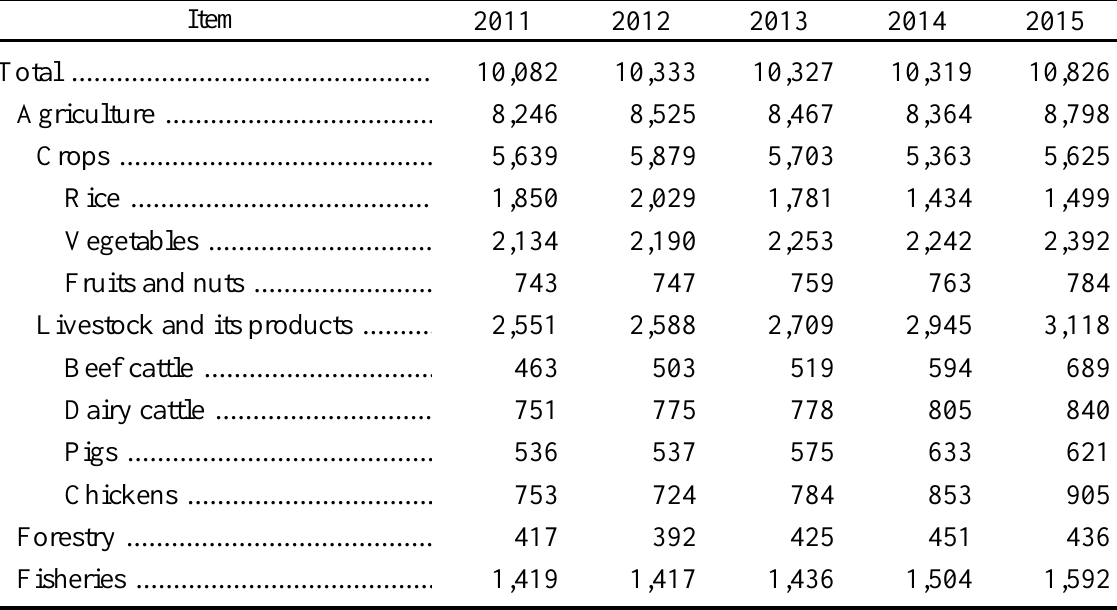
Agricultural, Forestry and Fisheries Output